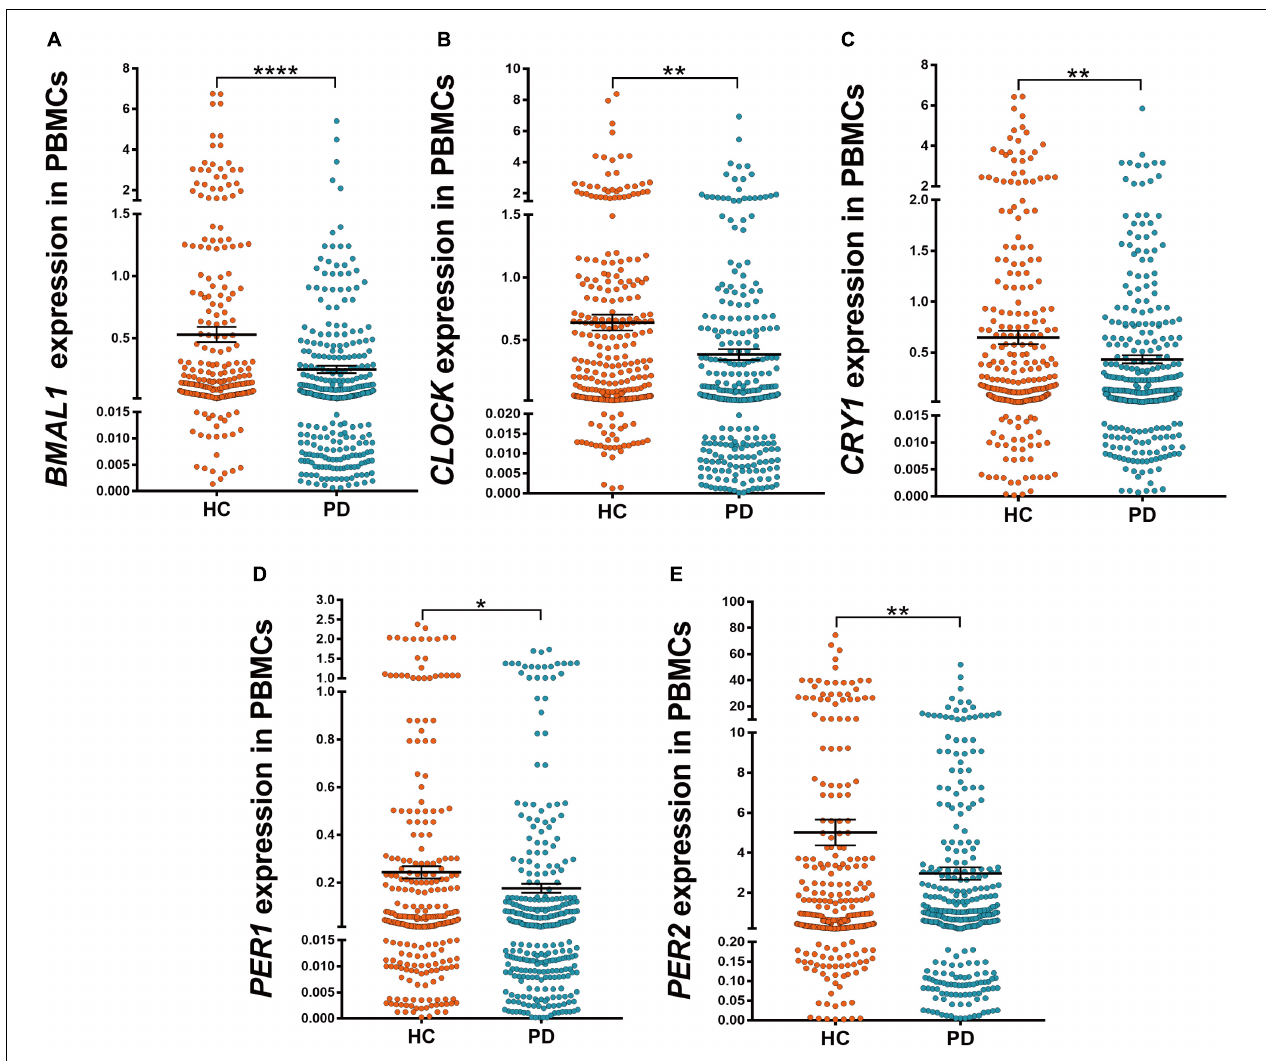
FIGURE 1 | Scatter plots of BMAL1 , CLOCK , CRY1 , PER1, and PER2 relative mRNA expression levels in the PBMCs of HC ( n = 314) and PD ( n = 326). (A–E) Significantly lower levels of BMAL1 ( A , P < 0.0001), CLOCK ( B , P < 0.01), CRY1 ( C , P < 0.01), PER1 ( D , P < 0.05) and PRY2 ( E , P < 0.01) were seen in PD patients compared to those in HC. Horizontal bars represent mean and SE values. * P < 0.05, ** P < 0.01, and **** P < 0.0001.